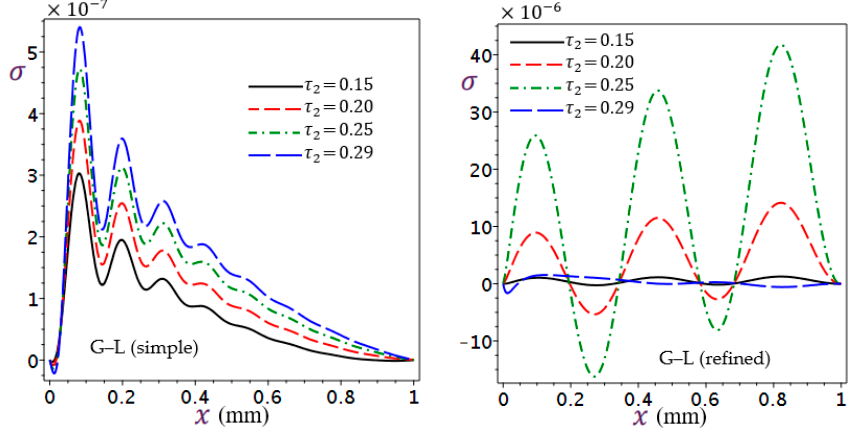
Figure 17. Effect of second relaxation time τ 2 of G–L theory on normal stress σ .